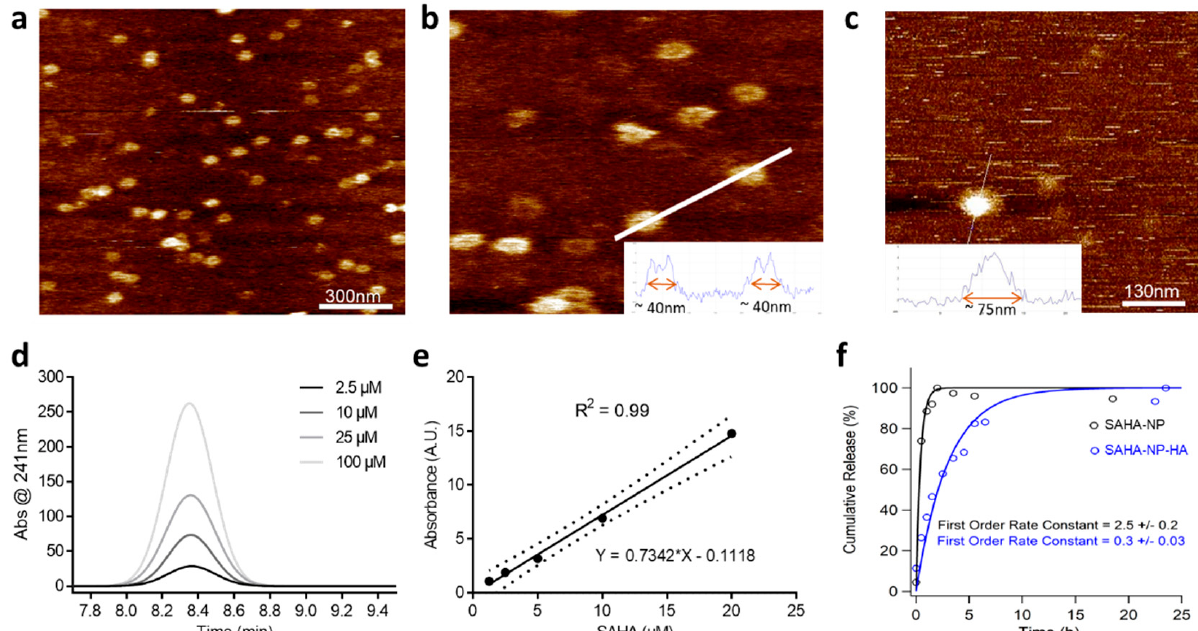
Figure 3. Nanoparticle AFM imaging. F127 nanoparticles were deposited on a mica substrate and analyzed by AFM. ( a ) NP topography showing the round shape. ( b ) Vertical line profile calculated along the solid white dotted line showing particle height around 40 nm. Scale bar 300 nm. ( c ) NP-HA image showing size and topography. Encapsulation efficiency and release profile HPLC chromatogram and calibration curve. SAHA encapsulation efficiency was calculated relative to a standard curve constructed from increasing SAHA concentrations from over range of 2.5 to 100 µ M (absorbance at 241 nm and retention time = 8.34 min) in DMSO solution, measured by HPLC ( d ). Calibration curve ( e ) and linear fitting are representative of that constructed independently for each particle preparation. The purity (based on AUC) was >95%. Cumulative passive SAHA release profiles from nanoparticles ( f ). Cumulative percentage as a proportion of the released drug, not total drug encapsulated. Data generated using LC-UV analysis. SAHA-NP (black line) and SAHA-NP-HA (blue line) release profiles with corresponding first order rate constant.